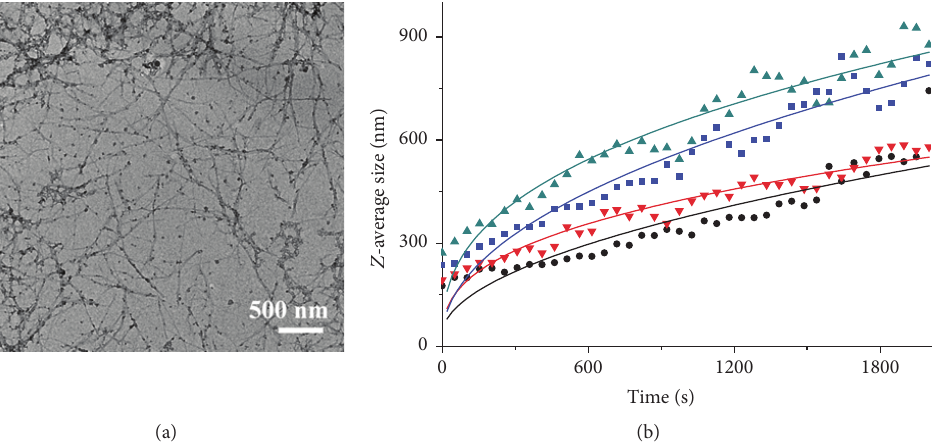
Figure 10: The influence of Al(III)/EGCG complex on the fibrillation and nucleation of hIAPP. (a) TEM image of 16 𝜇 M hIAPP incubated with 2 𝜇 M Al(III) and 2 𝜇 M EGCG for 2 h. (b) Dependence of 𝑍 -average size on the nucleation time of 16 𝜇 M hIAPP incubated without ( ◼ ), and with 2 𝜇 M EGCG ( e ), 2 𝜇 M Al(III) ( 󳵳 ), and 2 𝜇 M Al/EGCG in molar ration of 1: 1 ( 󳶃 ) by DLS assay. Solid lines represent the curves fitted using